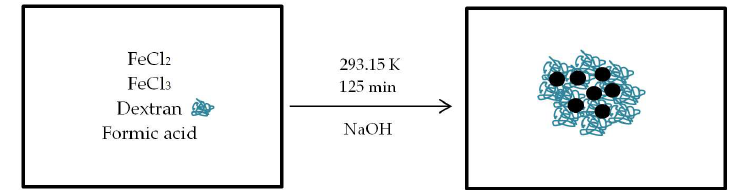
Figure 2. Schematic overview of multicore superparamagnetic iron oxide nanoparticle (MC-SPION) synthesis in aqueous media.